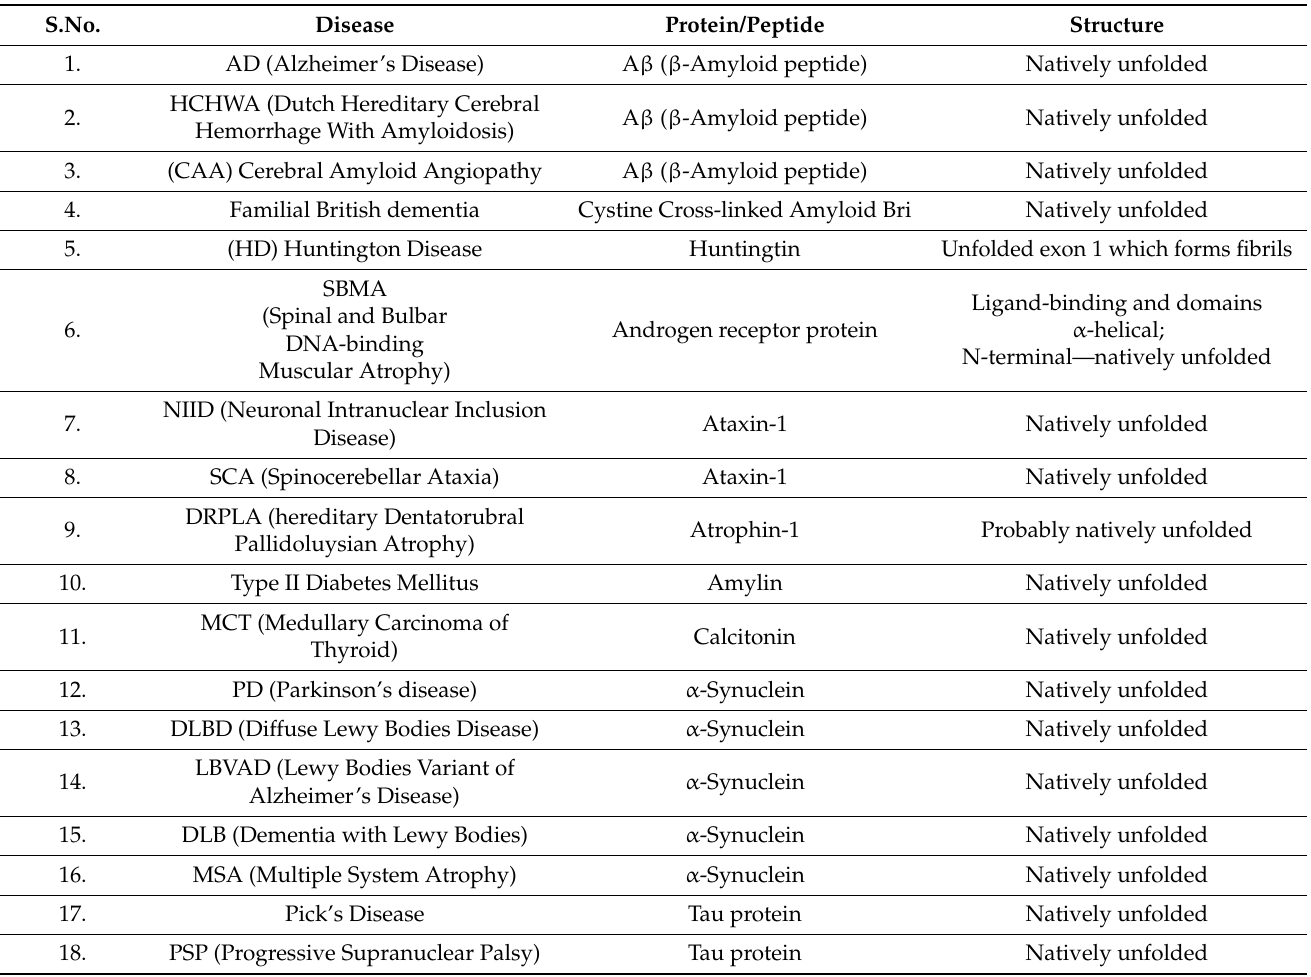
Table 2. Various amyloid related